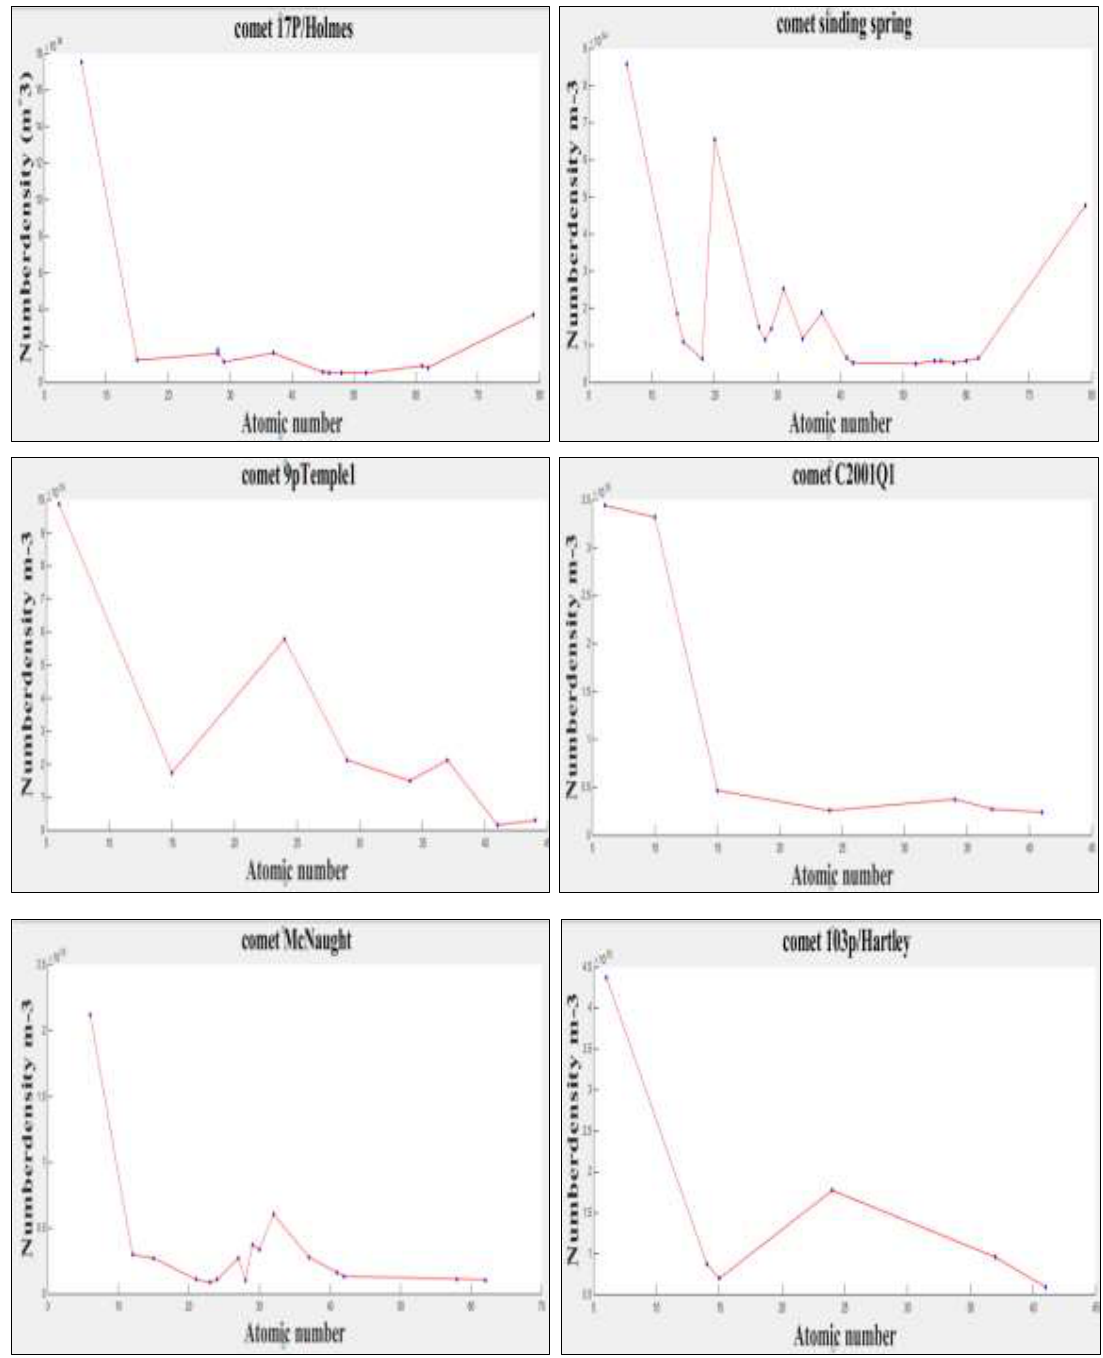
Figure 4: Comet number density versus atomic